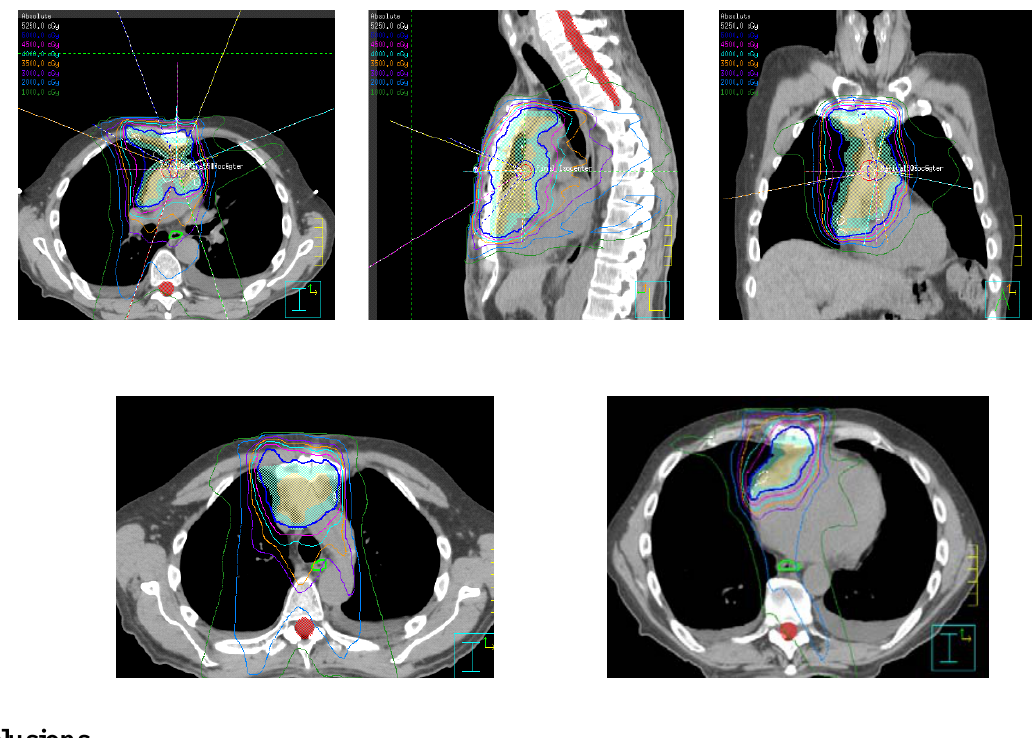
Figure 2. Representative postoperative treatment field in patient with locally advanced invasive